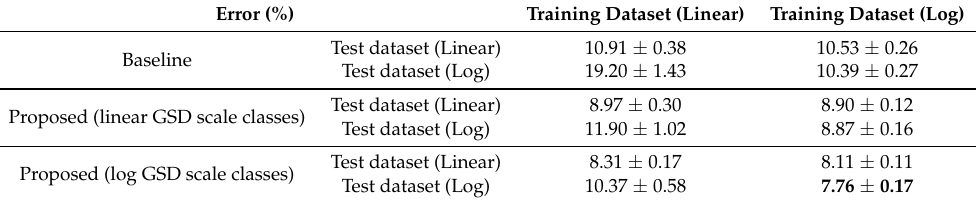
Table 3. Comparison of GSD prediction errors for the linear and the log GSD scale dataset 1.